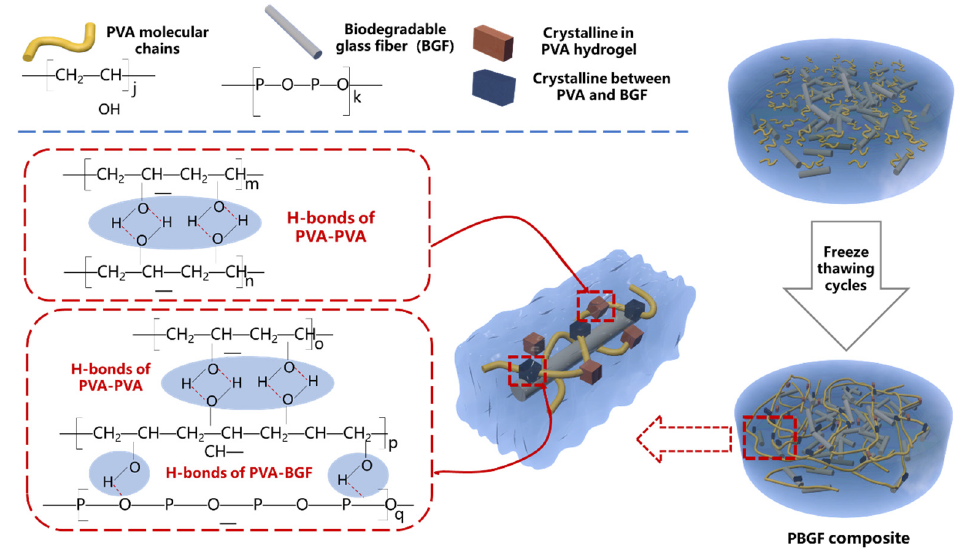
Figure 2. Schematic illustration of microstructure formation for PBGF composites.